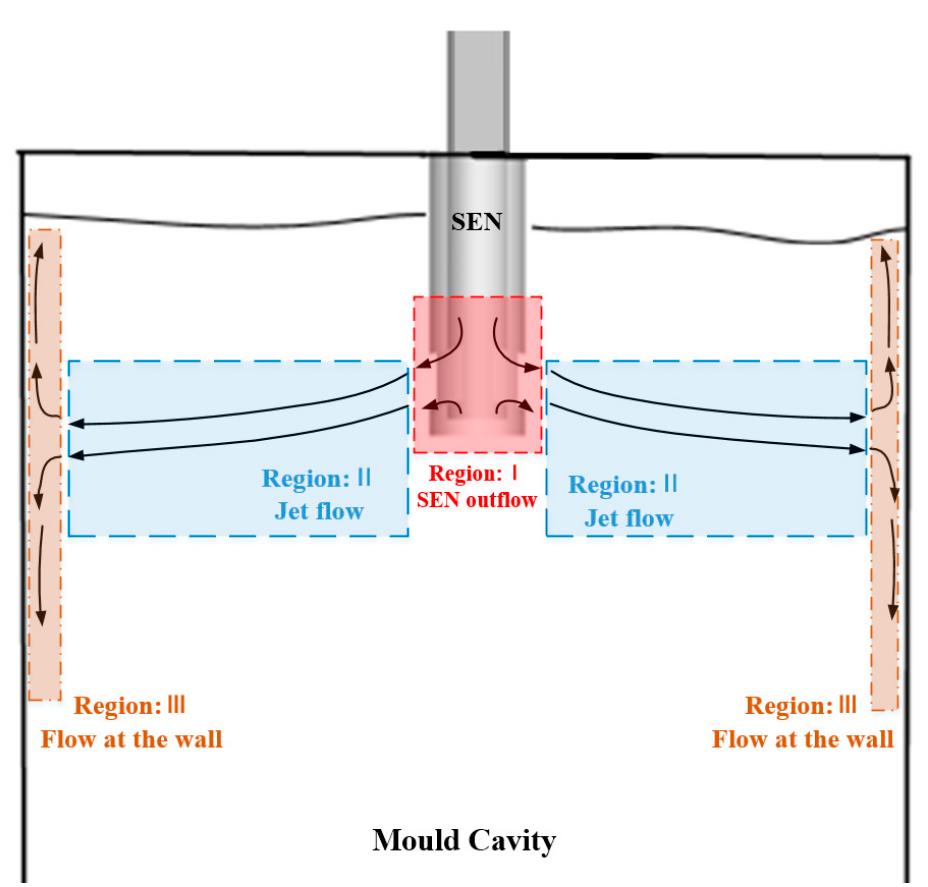
Figure 2. A typical flow region includes SEN outflow, jet flow, surface flow, and wall flow inside the mold.